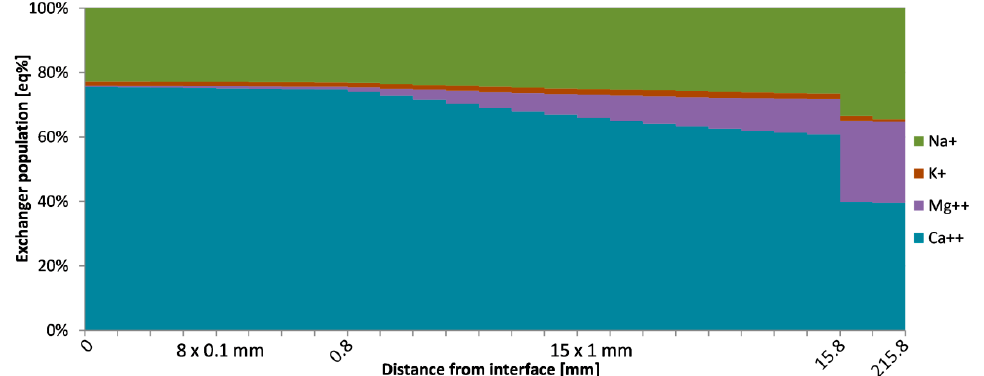
Figure 4. The cation concentration profile in the Donnan porewater (in charge equivalent fractions) across the OPA after 2.7 y of interaction with ESDRED. In the current modelling approach, the Donnan porewater concentrations replaced the cation occupancies of clay models with explicit ion-exchange. Explanation of horizontal axis in Figure 1 captions.